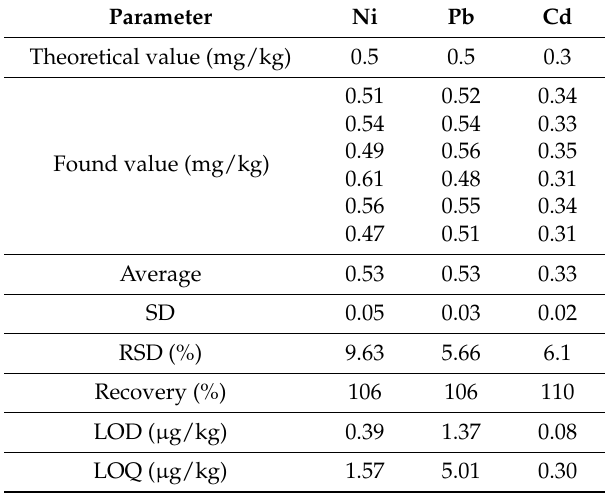
Table 5. Concentration of heavy metals in the reference